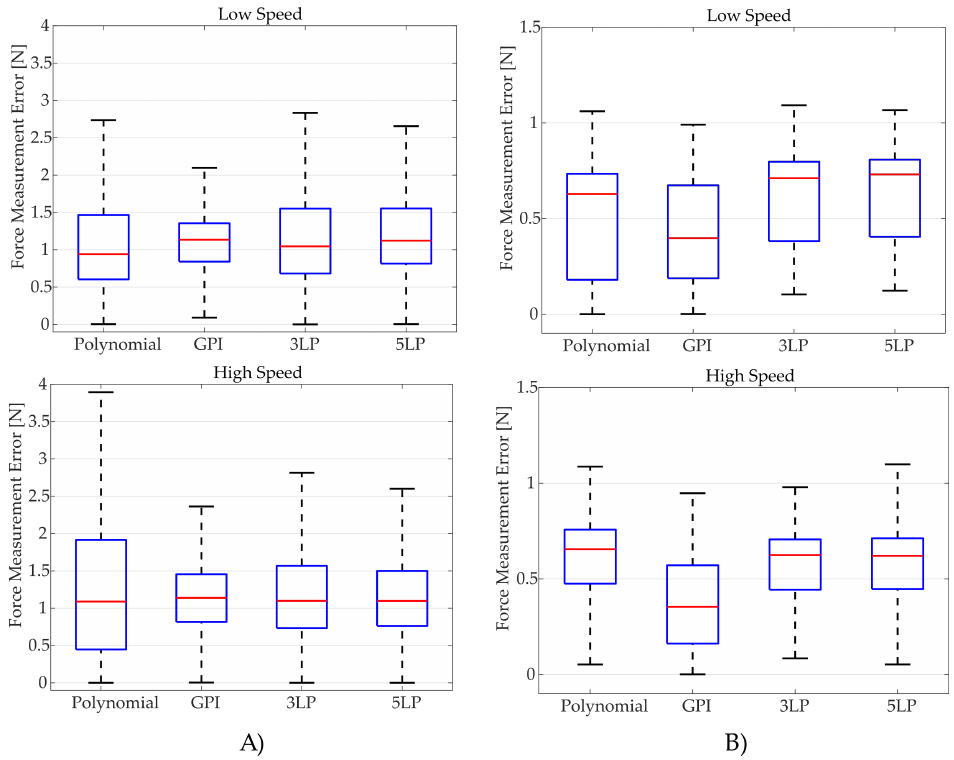
Figure A4. Error distribution computed for the Random Signal test and range of variation of the force. (Low Speed ≤ 5 N/s; High Speed > 5 N/s). Where ( A ) corresponds to the data of the PLA based sensor and ( B ) to the steel based sensor.